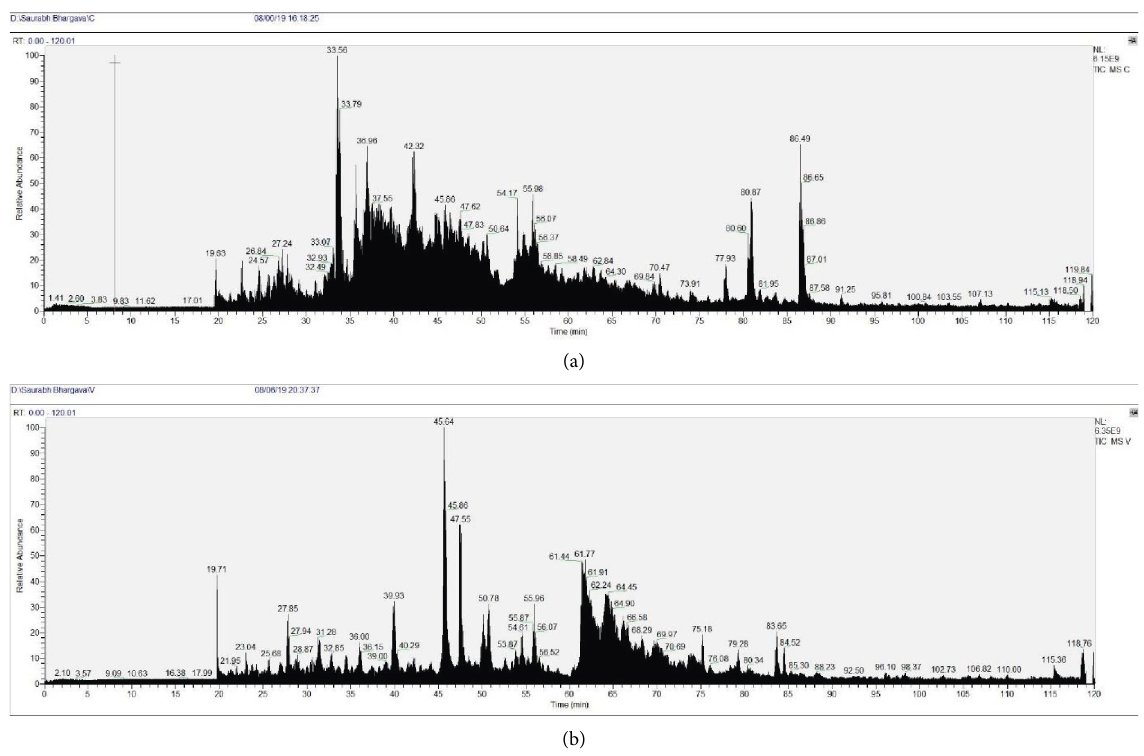
Figure 5: LC-MS/MS chromatograms of Naja naja venom (a) and Daboia russelii venom (b). Table 2: Various types of proteins found in LC-MS/MS of crude venoms of Naja naja and Daboia russelii. Sr. No. Protein/toxin Naja naja venom Daboia russelii